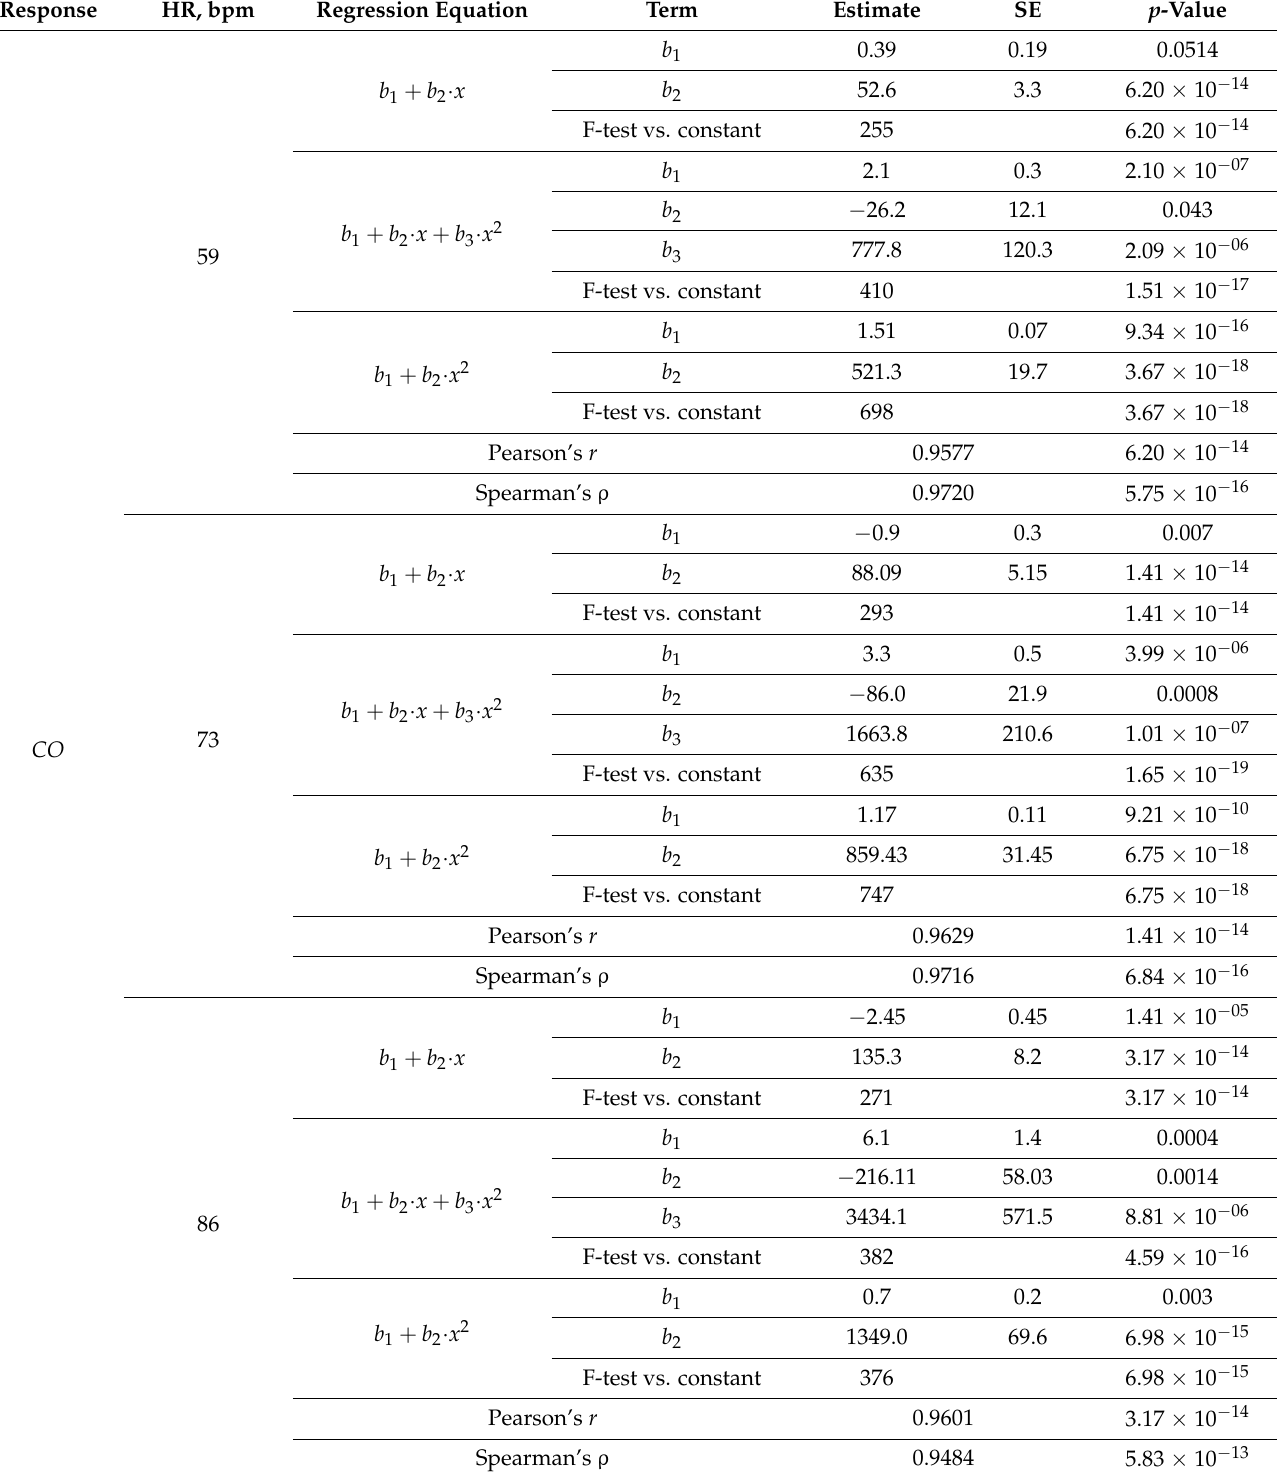
Table 1. Data of statistical analysis of different regression models for CO